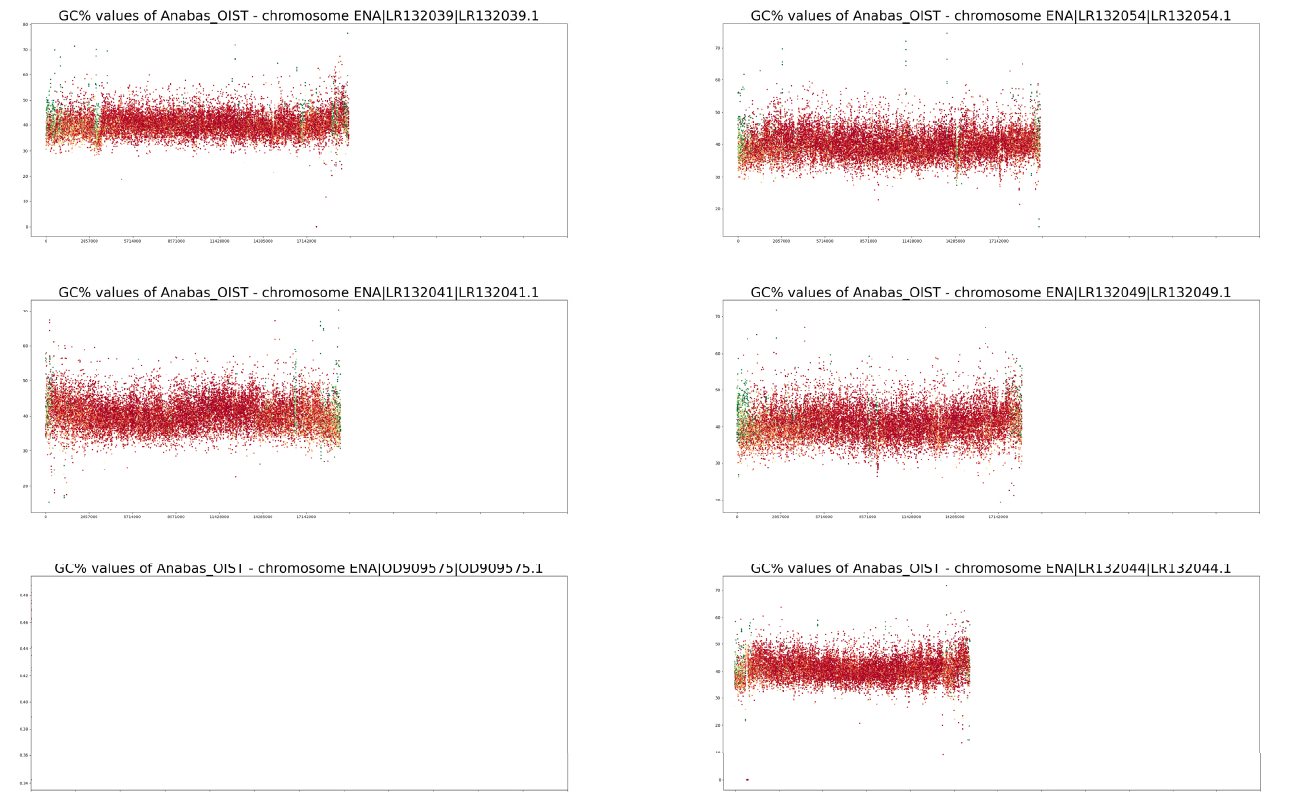
Figure A2. GC% and rep% profiles of chromosomes in Anabas testudineus soft-masked in this study